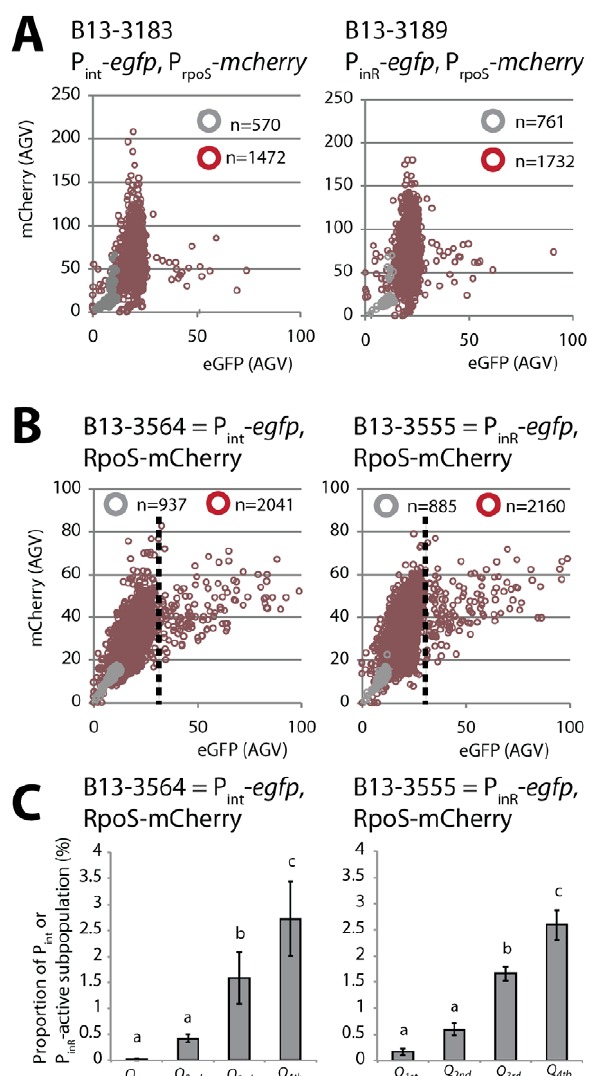
Figure 4. Correlation between rpoS and either P int or P inR expression in P.knackmussii B13. (A) Scatter plots of scaled single cell mCherry fluorescence expressed from P rpoS and eGFP from P int (left panel) or P inR (right panel) in cultures on 3CBA in exponential phase (grey circles) or after 24 h in stationary phase (red-brown circles). (B) As A but showing single cell fluorescence of an RpoS-mCherry fusion protein (under transcriptional control from P rpoS ) versus eGFP fluores- cence from P int (left panel) or P inR (right panel). Note that in strain B13- 3564 and B13-3555 the native rpoS gene is replaced by rpoS-mcherry . Every circle represents measurements on a single cell. The total number of measured cells is displayed in every diagram. (C) Proportion of cells expressing eGFP above threshold (dotted lines in panel B) from P int (left panel) or P inR (right panel) in data sets of panel B per quadrant ( Q ) of normal distributed RpoS-mCherry intensity. Q 1st , from minimum to Q 1 (mean 2 1 SD ); Q 2nd , from Q 1 to Q 2 (mean); Q 3d , from Q 2 to Q 3 (mean + 1 SD ); Q 4th , from Q 3 to maximum. Letters above bar diagrams indicate significance of difference (P , 0.05) in a Tukey’s post-hoc test on sample variances (one-way ANOVA).